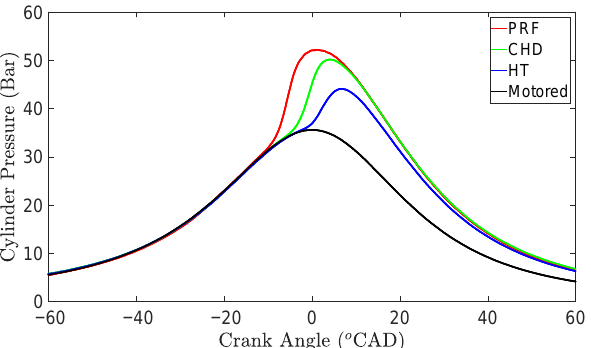
Figure 9. Combustion pressure for the three fuels and motored pressure with T inlet 115 ◦